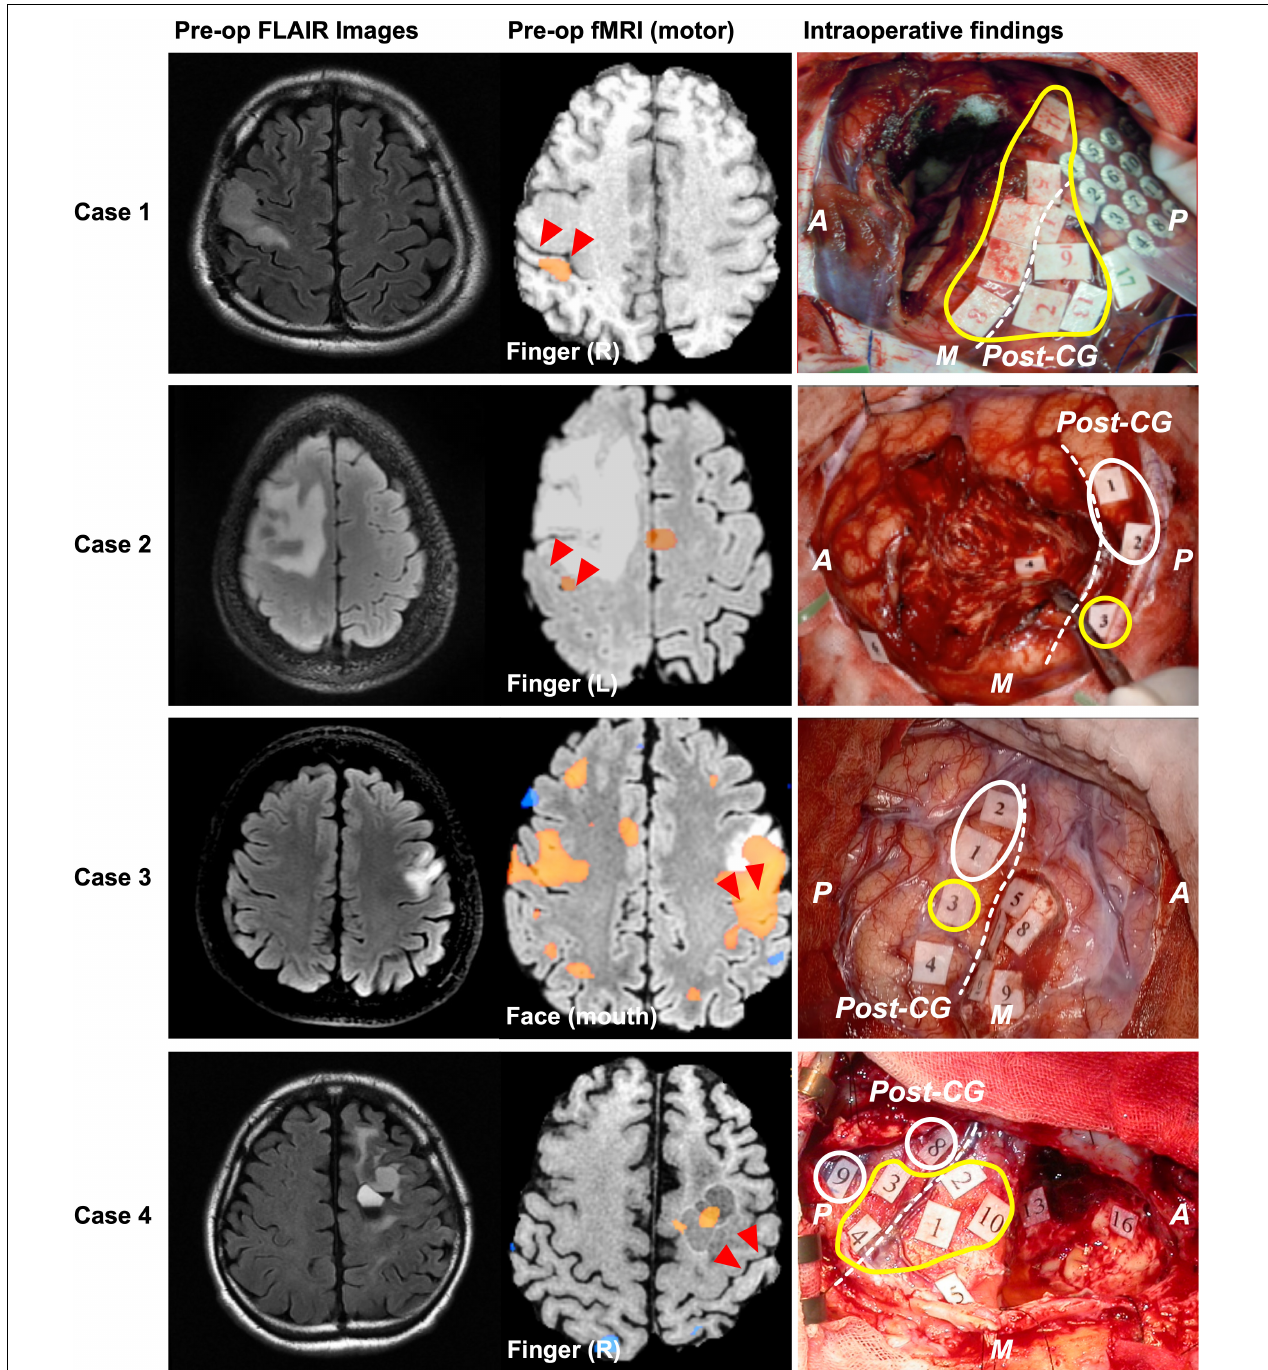
FIGURE 3 | Patients whose motor functions shifted in Type 1. The left, middle, and right columns show the preoperative FLAIR images, preoperative functional MRI for movement, and intraoperative findings, respectively. In Cases 1 and 2, blood oxygenation level dependency (BOLD) was observed in the postcentral gyrus during the movement task. However, in Case 4, BOLD dependency was observed within the resection cavity of previous surgery, but not in the precentral or postcentral gyrus. Positive mapping sites for movement were found in the postcentral gyrus of four patients during awake surgery. In Cases 1 and 4, positive motor responses were elicited in both the precentral and the postcentral gyri. However, in Cases 2 and 3, positive motor responses were only found in the postcentral gyrus. The red triangles in the middle column and white broken line in the right column indicate the central sulcus; the yellow circles indicate positive mappings for motor function sites; the white circles indicate positive mappings for sensory sites. A: anterior; P: posterior; M: medial side; CG: central gyrus. Here, we show Tags and symptoms elicited by electrical stimulation except for sensory and motor. Case 1: Tag 17, sensory; Case 2: Tag 4, negative motor response (foot); Tag 6, emotion recognition; Case 3: Tags 4, 6, and 7, dysarthria; Tags 5 and 9, anarthria; Tag 8, negative motor response; Case 4: Tags 5, 13, and 16, paraphasia.